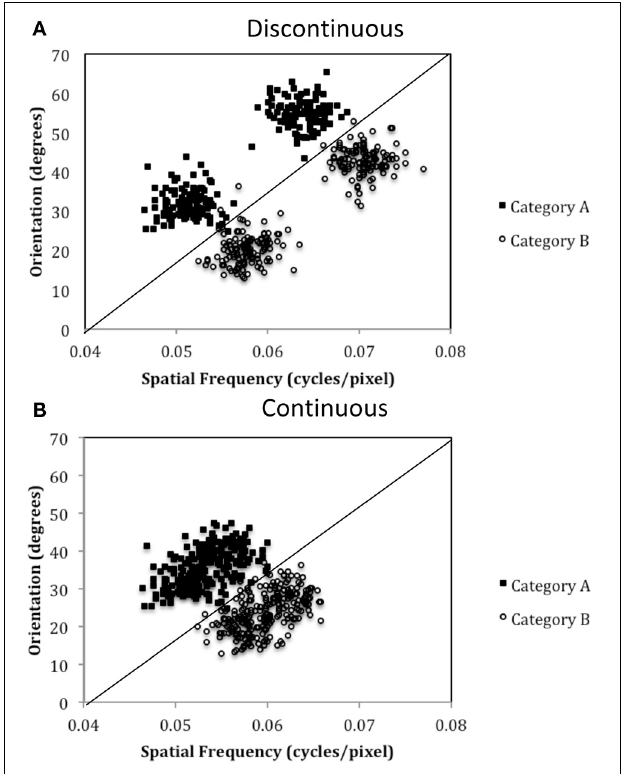
FIGURE 6 | Stimulus distributions for the (A) Discontinuous and (B) Continuous conditions in Experiment 2. The solid line represents the optimal